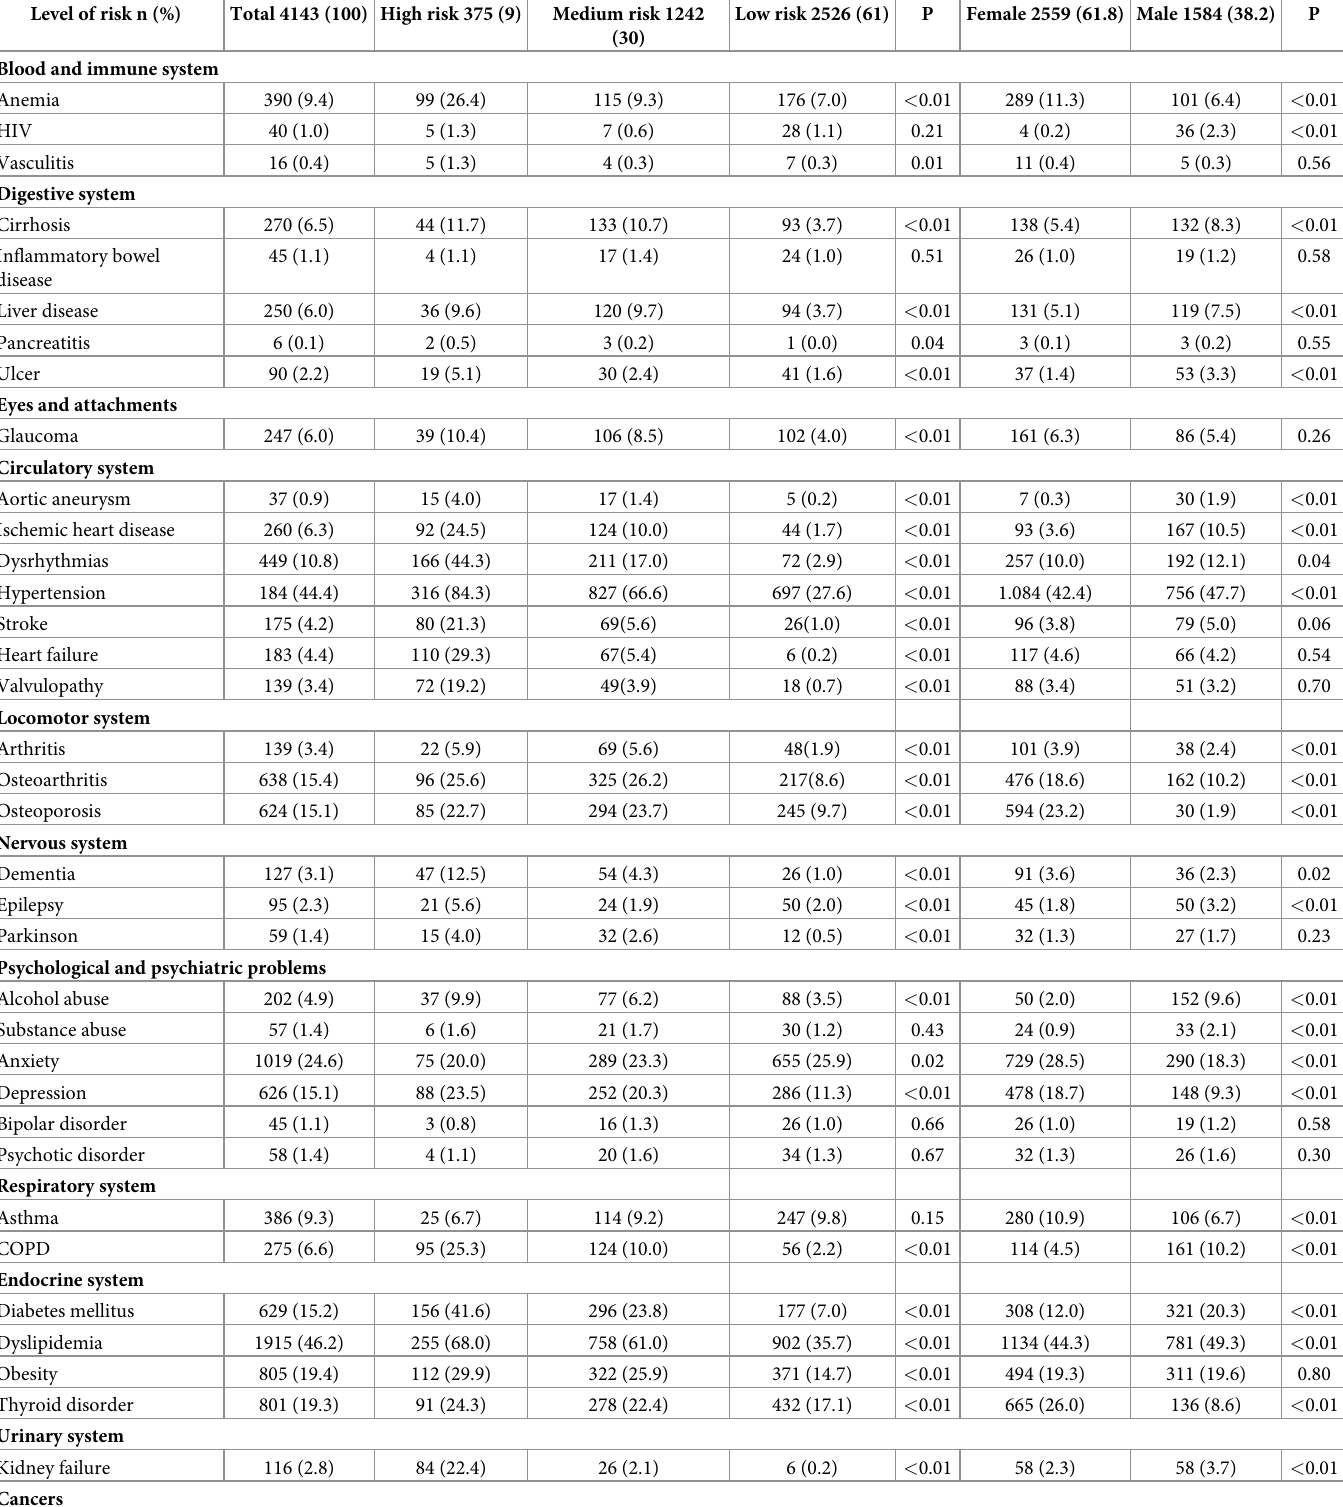
Table 2. Distribution of the most prevalent chronic diseases in the population in the basic health area overall and stratified by risk level and sex. Level of risk n